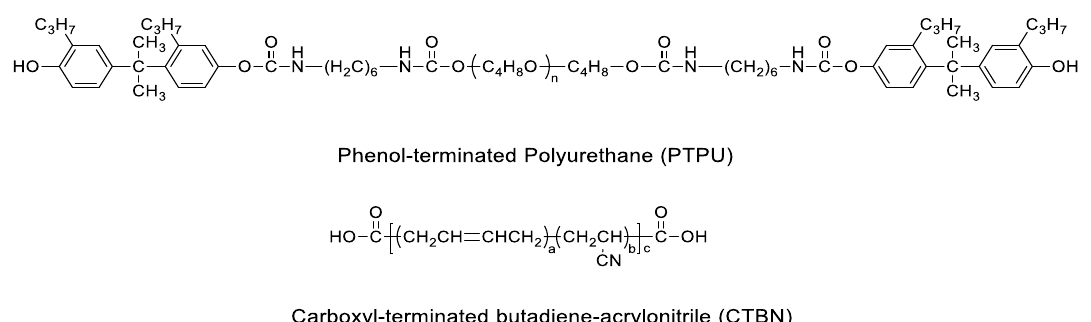
Figure 1. Chemical structures of phenol-terminated polyurethane (PTPU) and carboxyl-terminated butadiene acrylonitrile (CTBN).